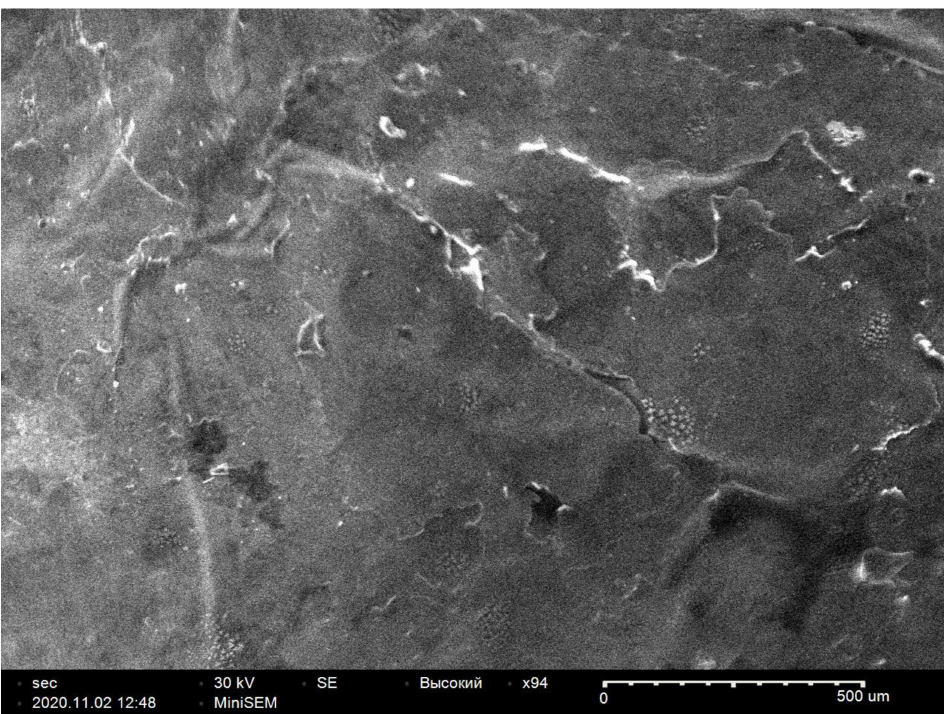
Figure 5. The surface of vermiculite (SNE 4500M